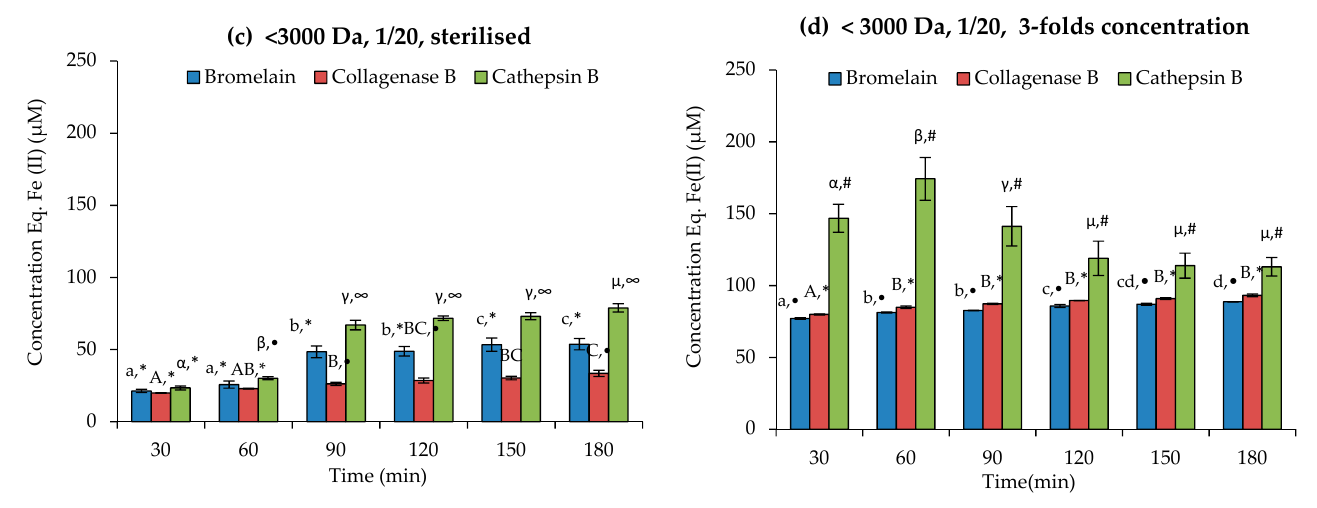
Figure 5. Concentration of Fe(II), after reduction of Fe(III) by the peptides-minerals complexes, et the ratio E:C 1/20 ( a ) and 1/50 ( b ); after sterilisation ( c ); after 3-folds concentration, E:C 1/20 ( d ). Columns label interpretation: (i) different lowercase letters indicate differences over time for complexes obtained by bromelain; (ii) different uppercase letters indicate differences over time for complexes obtained by collagenase B; (iii) different Greek letters indicate differences over time for complexes obtained by cathepsin B; (iv) different symbols indicate differences among peptide-mineral complexes according to the enzyme.